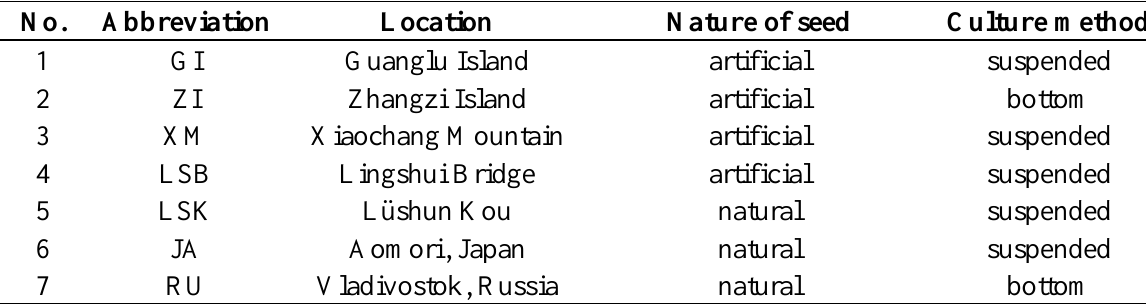
Table 1. Samples used in the present